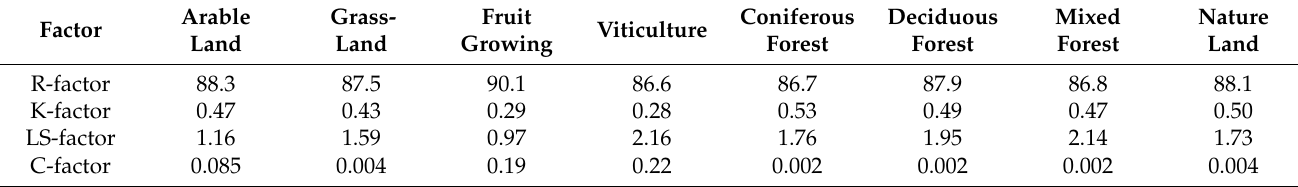
Table 4. USLE factors for the catchment of the Kraichbach river for different land uses.